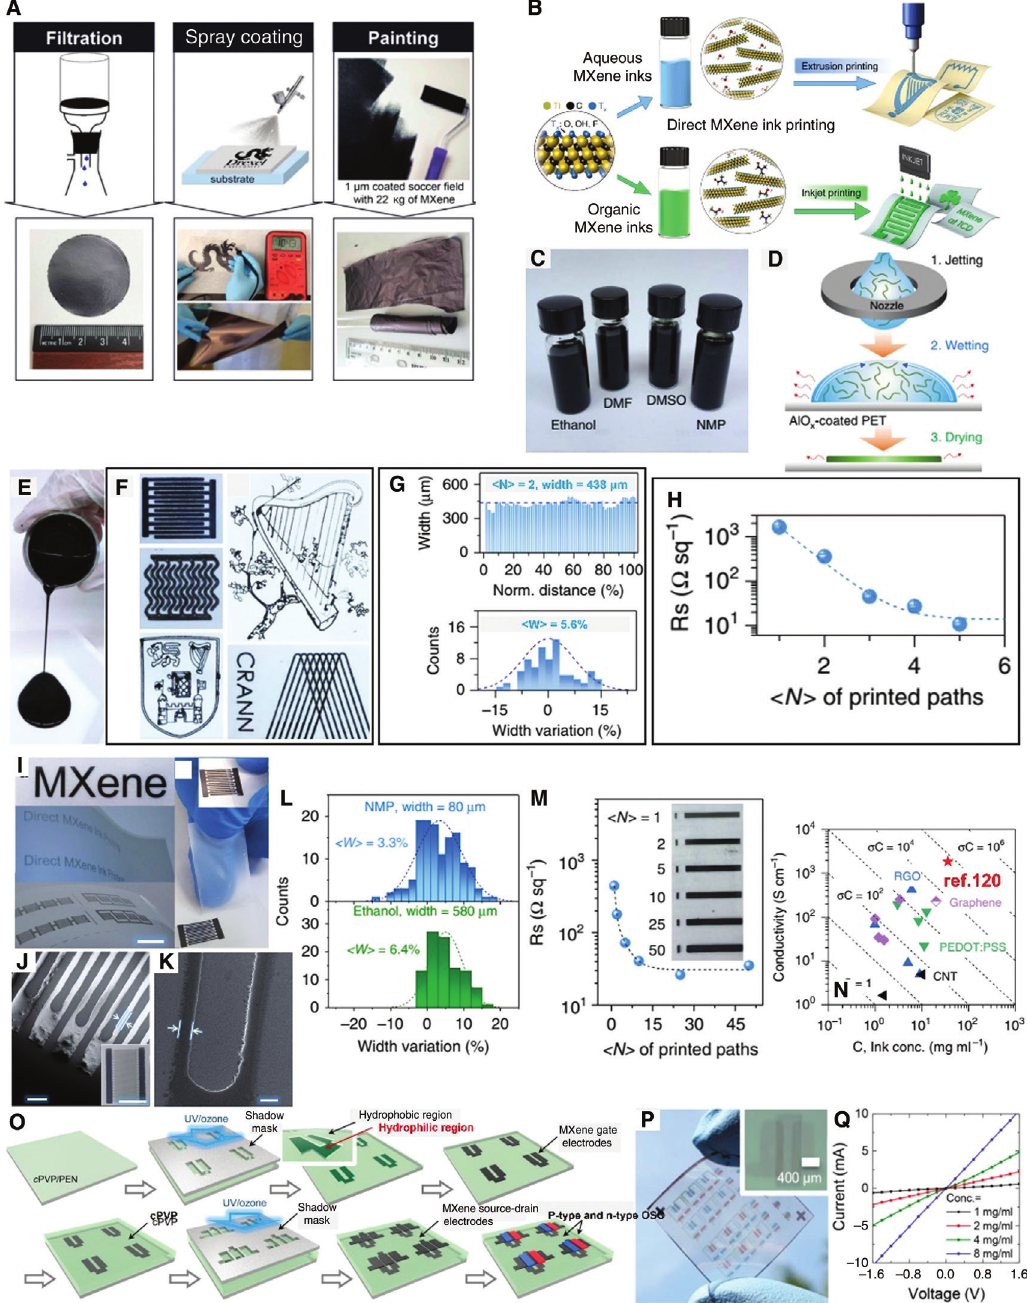
Figure 4: Fabrication methods and performances of scalable MXenes. (A) Overview of fabrication of Ti C T MXene electrically conducting films by vacuum-assisted filtration (left), spray-coating (middle), and 3 2 x painting (right) of MXene ink over various flexible substrates. (B) Schematic illustration of direct MXene ink writing process of extrusion printing with aqueous MXene ink (top), and inkjet printing with organic MXene inks (bottom). (C) Image of prepared organic MXene inks. (D) Conceptual image of inkjet printing. (E) Image of prepared aqueous MXene ink. (F) Various patterned MXene conductive films using extrusion printing. (G) Width distribution and resultant width spatial uniformity of extrusion-printed MXenes. (I) Optical images of inkjet- printed MXenes on AlO -coated PET substrate, scale bar is 1 cm. (L) Width variation of inkjet-printed MXene lines printed using NMP (top) x and ethanol (bottom) inks. (M) Measured sheet resistance (Rs) depending on printing number < N > , and optical images of various printed lines with different < N > (inset). (O) Comparison of σ C (S/cm) vs. concentration of ink as the FoM to show electronic network properties of a printable ink. (P) Schematic diagram showing fabrication of OFET with Ti C T MXene as the gate, drain, and source electrodes. (Q) 3 2 x Photographic image of MXene-electrode-based OFETs and logic gates on plastic substrate. (R) I-V curve showing electric conductivity of MXene electrodes. (A) Reproduced with permission [21], Copyright 2017, America Chemical Society. (B–O) Reproduced with permission [109], Copyright 2019, Nature Publishing Group. (P–R) Reproduced with permission [110], Copyright 2019, American Chemical